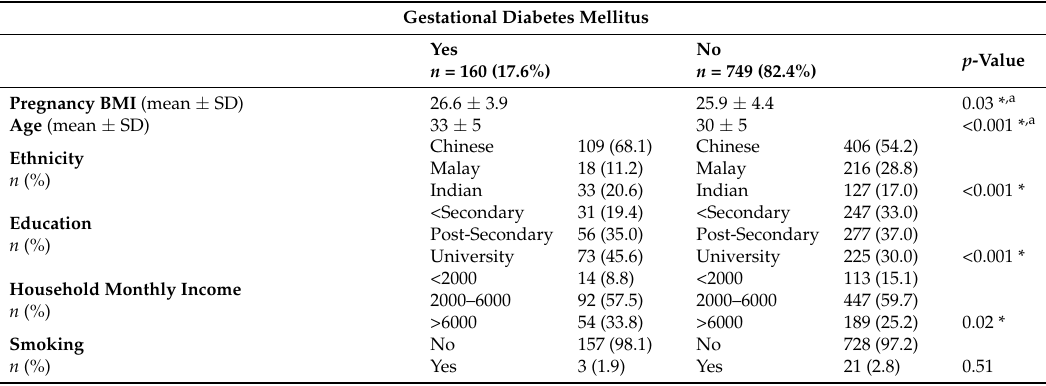
Figure 1. Flowchart showing selection of participants included in this analysis from GUSTO study (Growing up in Singapore towards healthy outcomes), Singapore. Table 1. Participant